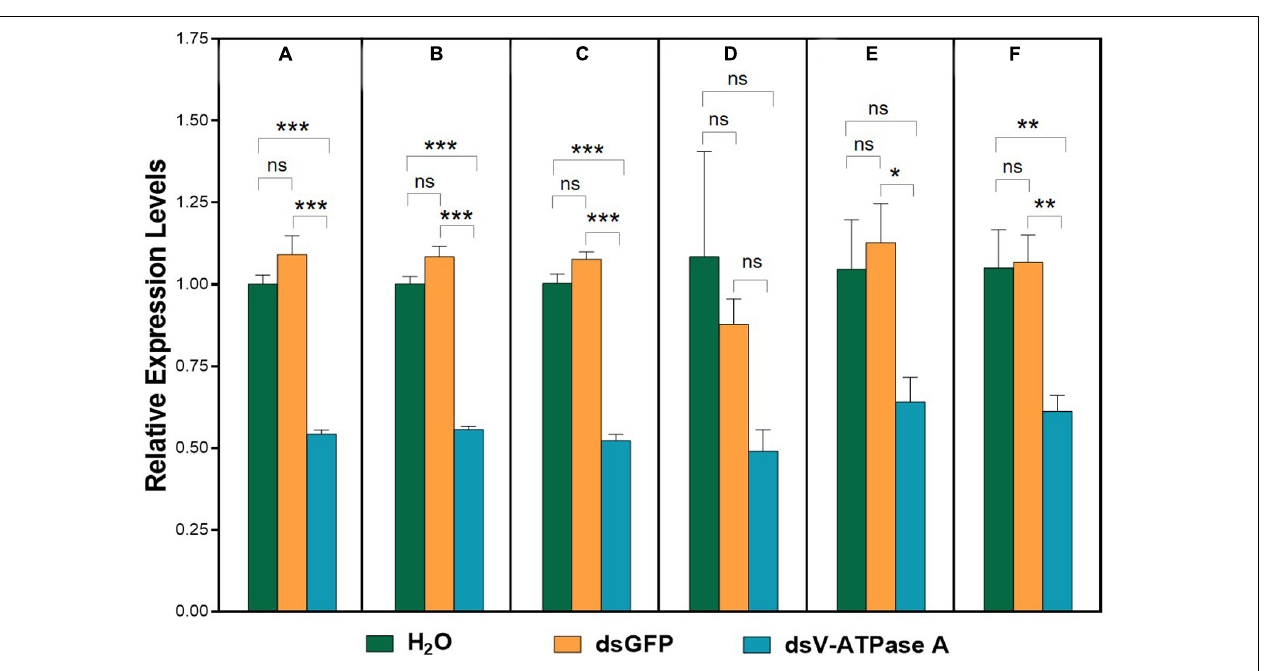
Frontiers in Physiology |